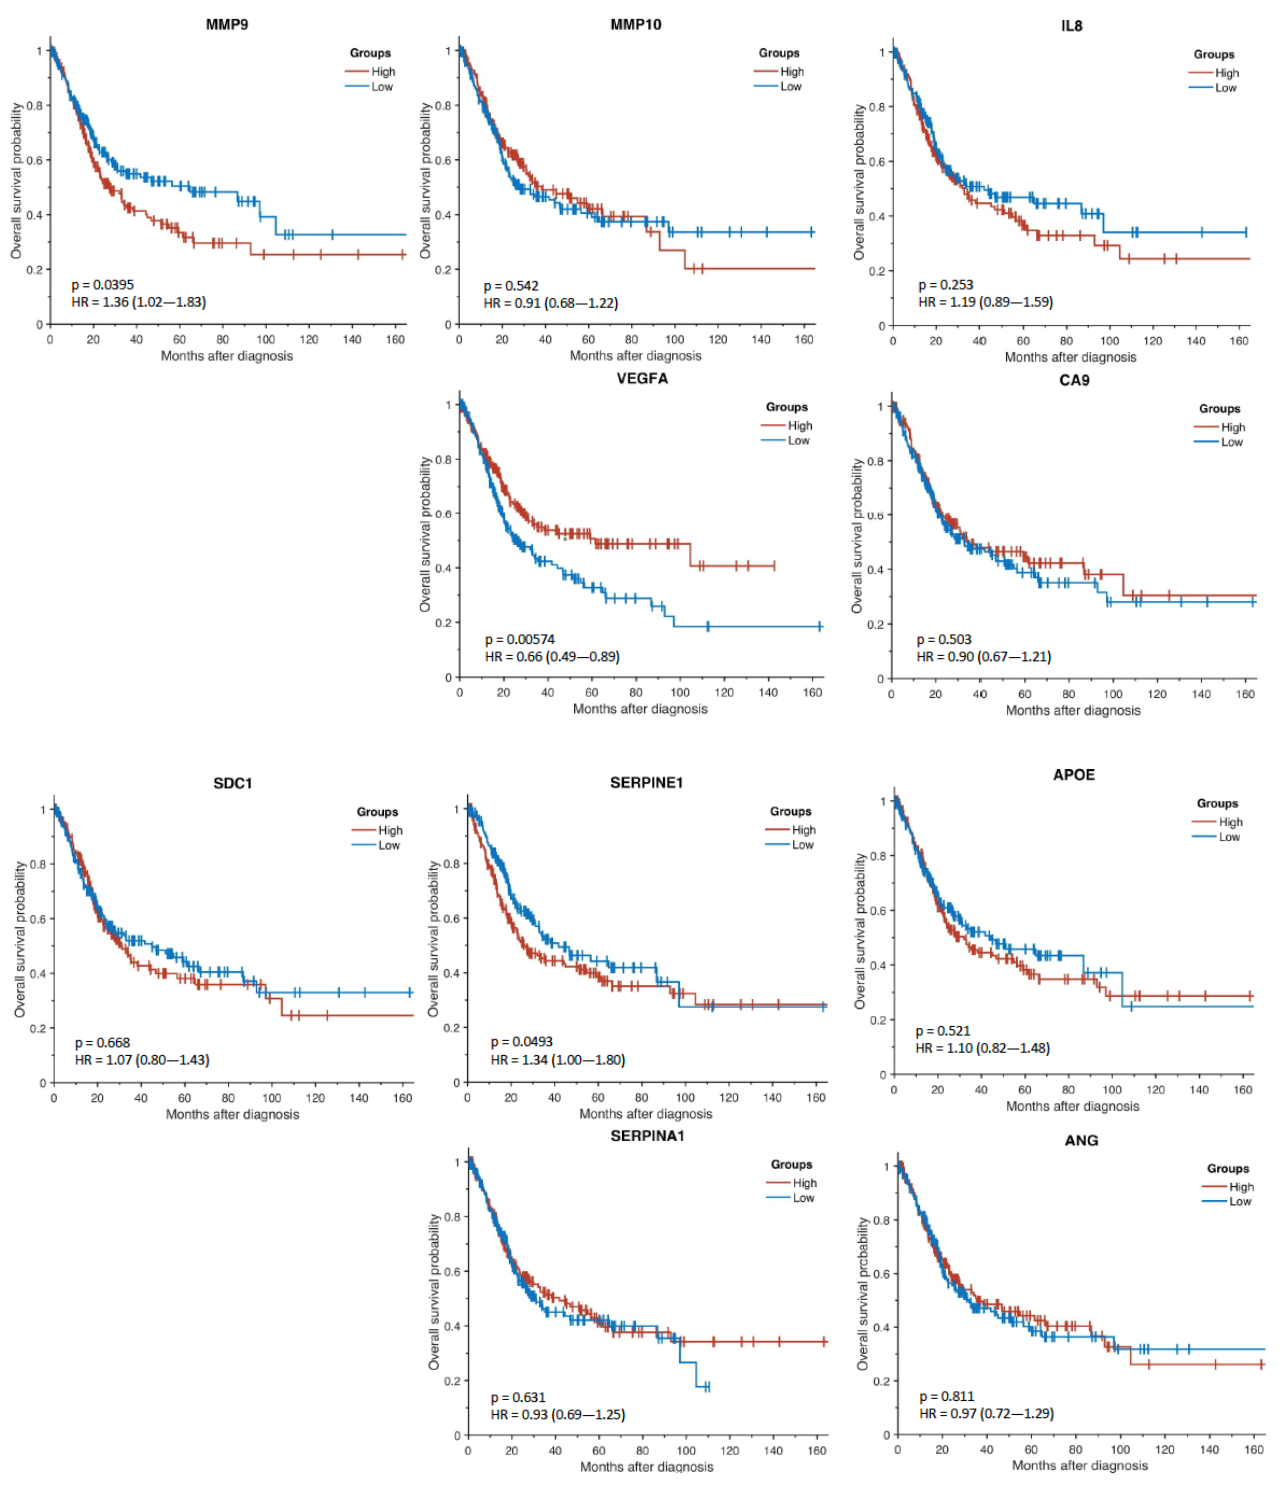
Figure 3. Kaplan–Meier survival curves for each of the 10 Oncuria™ biomarkers in the TCGA co ‐ hort.